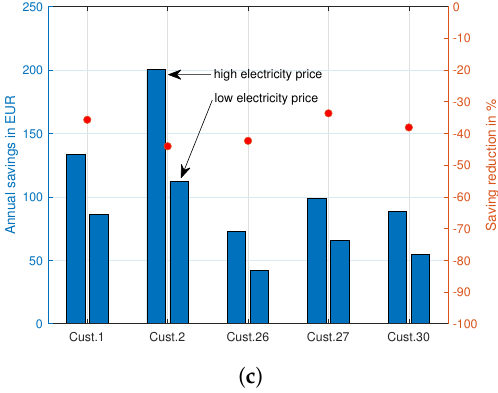
Figure 5. The impact of a decrease in per-unit energy prices for SFH owners with a private PV system. ( a ) Purely residential. ( b ) Residential and stand-alone PV. ( c ) Residential, stand-alone PV